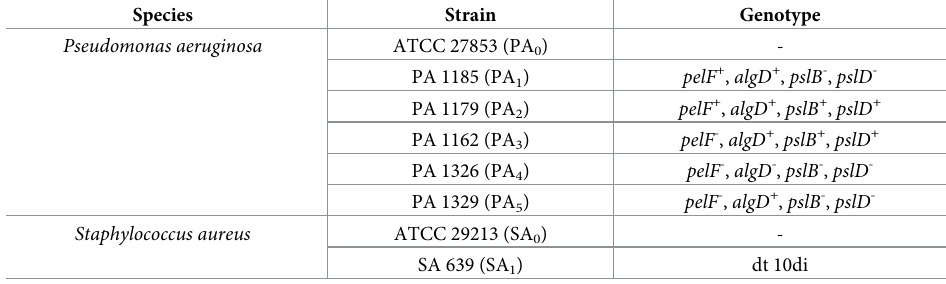
Table 1. Overview of strains used in this